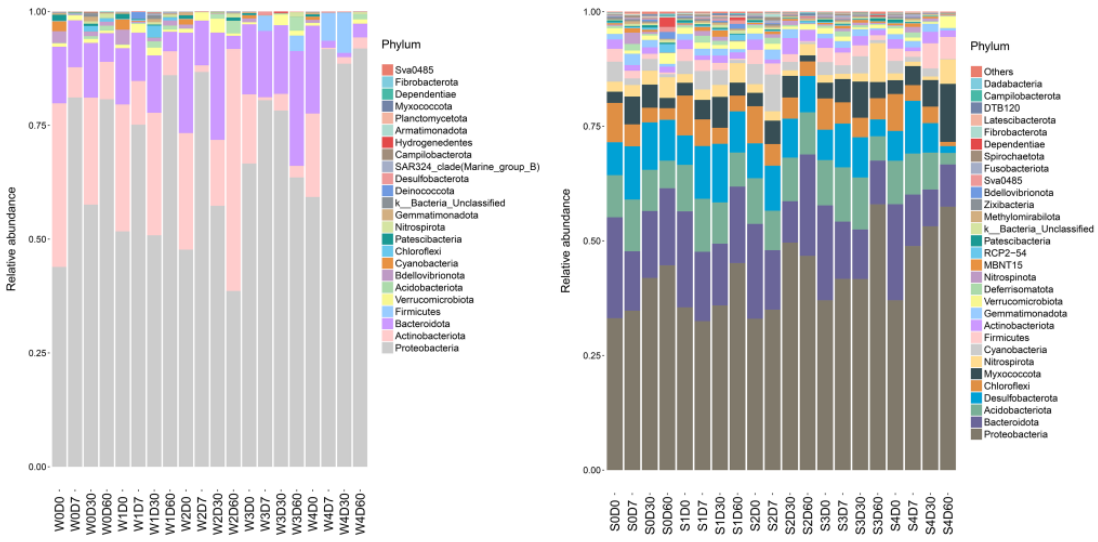
Figure 4. Effects of different concentrations of florfenicol on phylum-level bacterial abundance in an aquatic microcosm model. W, water; S, sediments.